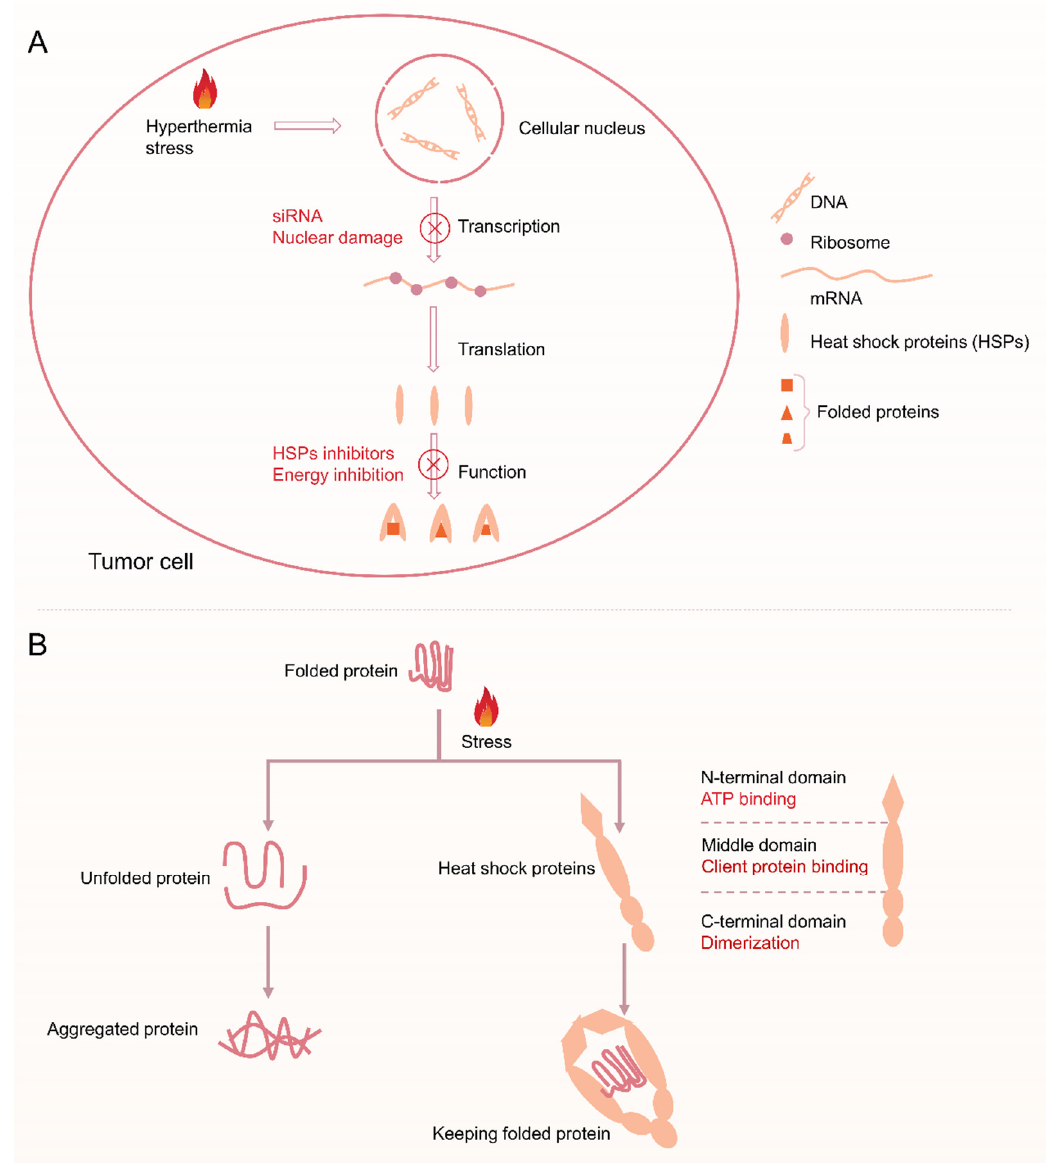
Figure 2. ( A ) Schematic of the process of heat shock reaction after hyperthermia and the blocking function of heat shock reaction via siRNA, nuclear damage, HSPs inhibitors, and energy inhibition. ( B ) Illustrating the physiological functions of HSPs: assists protein folding into its native form in MTPTT.